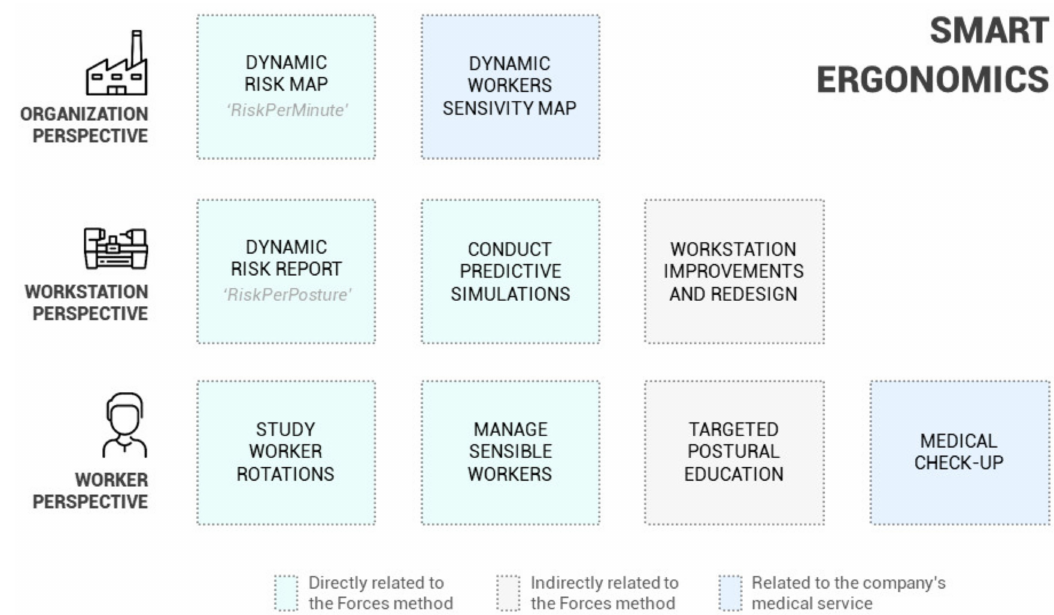
Figure 9. Relevant ergonomic actions for intelligent ergonomics and its connection with